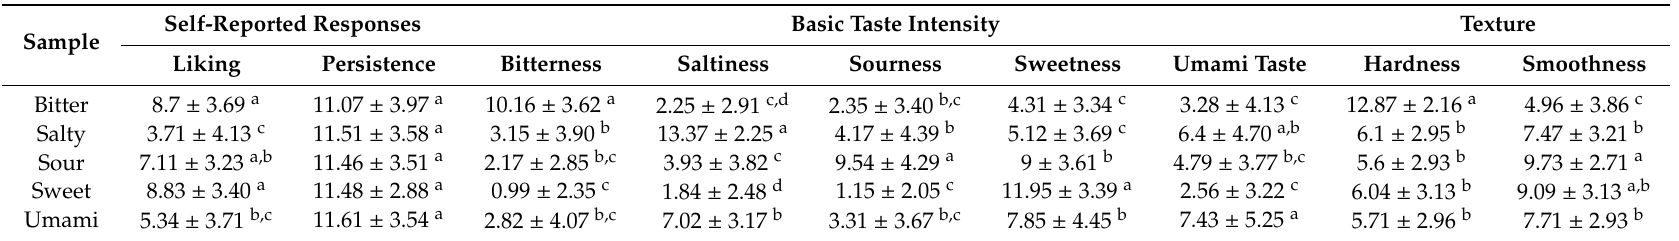
Table 4. Mean values for conscious responses (basic taste intensity, texture, and other self-reported responses) of chocolate samples.